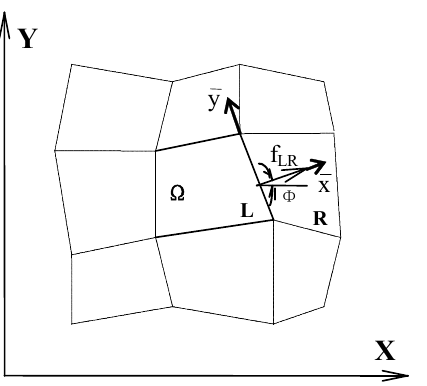
Figure 4. Finite volume Ω , where x is left side of the boundary, y is right side of the boundary, f LR is Figure 4. Finite volume Ω , where x̄ is left side of the boundary, ȳ is right side of the boundary, f (cid:2896)(cid:2902) flux and Φ is the angle in the normal direction of the is flux and Φ is the angle in the normal direction of the boundary.